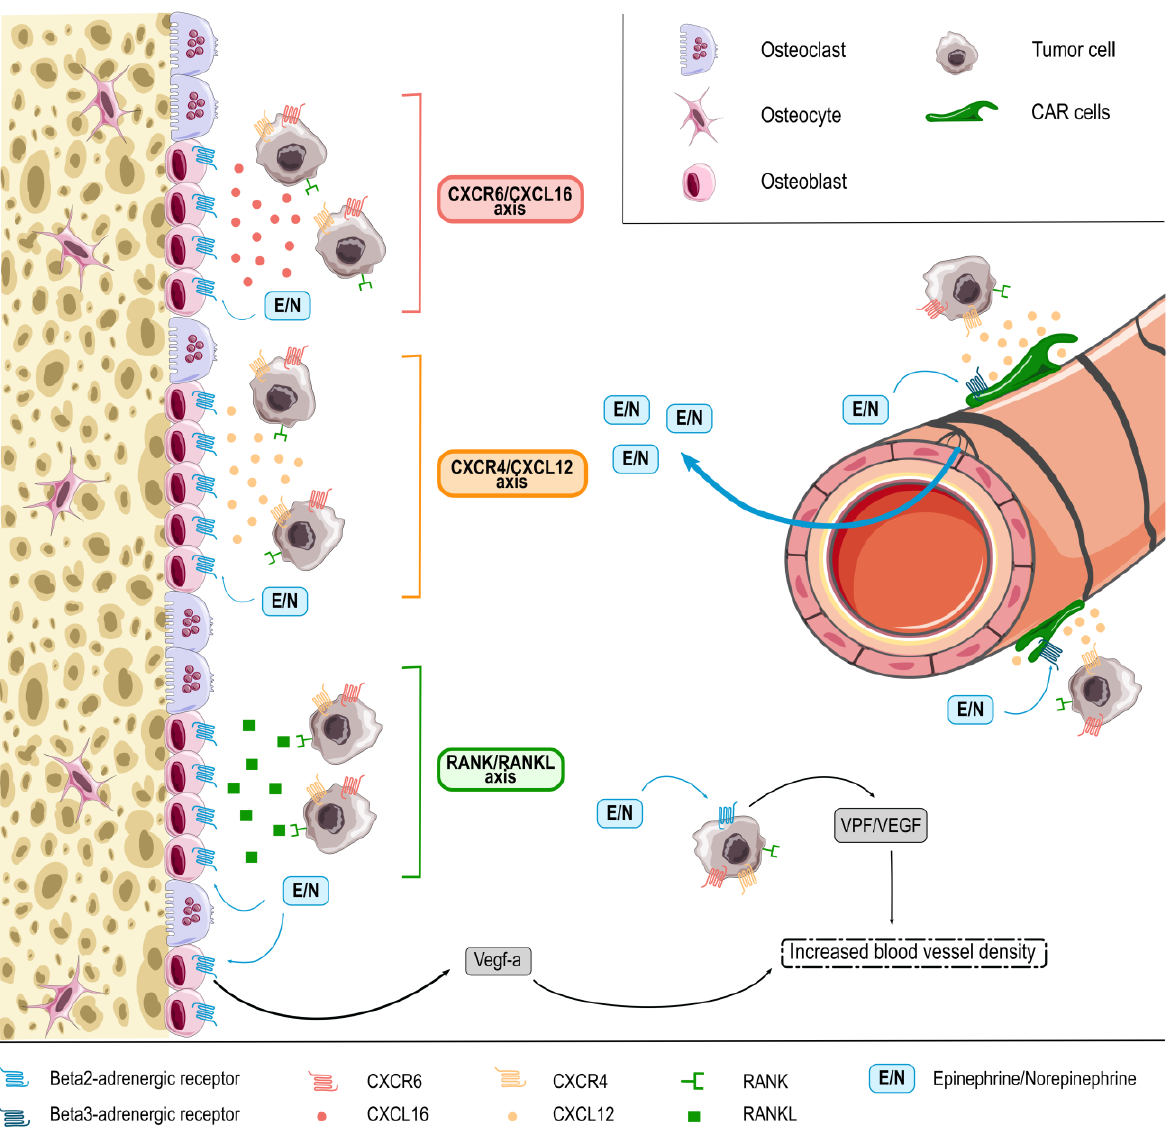
FIGURE 1: EPI and NOR (E/N, blue square) are released in the BM microenvironment from SNS fibers entering the bone with blood ves- sels. EPI and NOR influence interaction of tumor cells with  -ARs -expressing BM niche cells, e.g. CXCL12 abundant reticular (CAR) cells, osteoblasts and osteoclasts through different axis. In response to adrenergic signaling niche cells release (1) CXCL16 chemokine (red) that interacts with CXCR6 expressed on the surface of several tumor cells types, (2) CXCL12 (orange) that chemoattracts CXCR4 expressing cancer cells and (3) RANKL (green) protein that binds RANK-expressing malignant cells. In addition, adrenergic signaling in osteoblasts and also directly in tumor cells themselves can promote release of angiogenic factors thus promoting BM colonization by tumor cells through increased blood vessel OPEN ACCESS | www.cell-stress.com